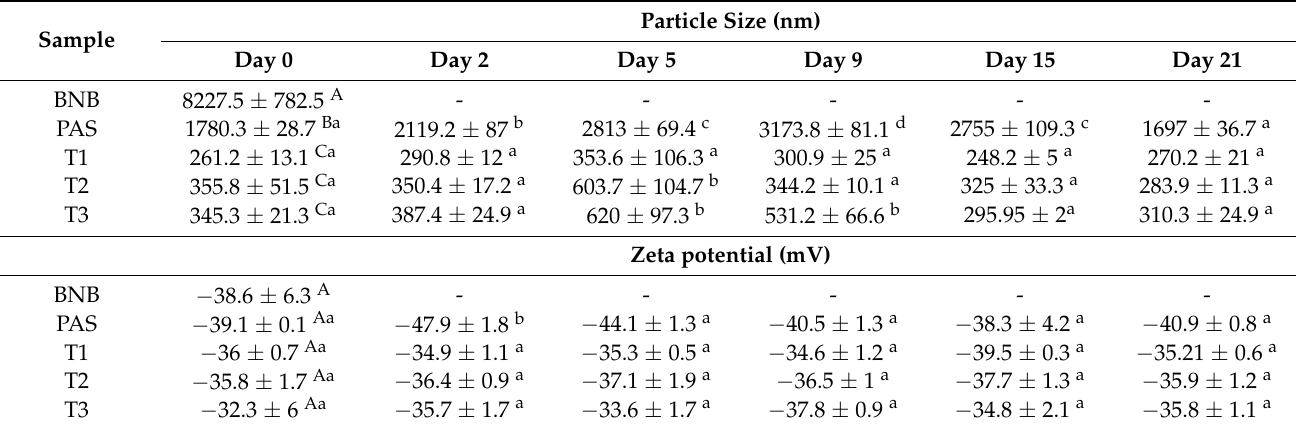
Table 4. Mean particle size and zeta potential of HPH-treated, pasteurized, and untreated Brazil nut beverages cold-stored for 21